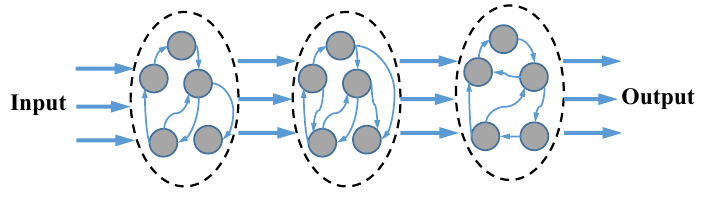
Figure 2. A synfire chain network with 3